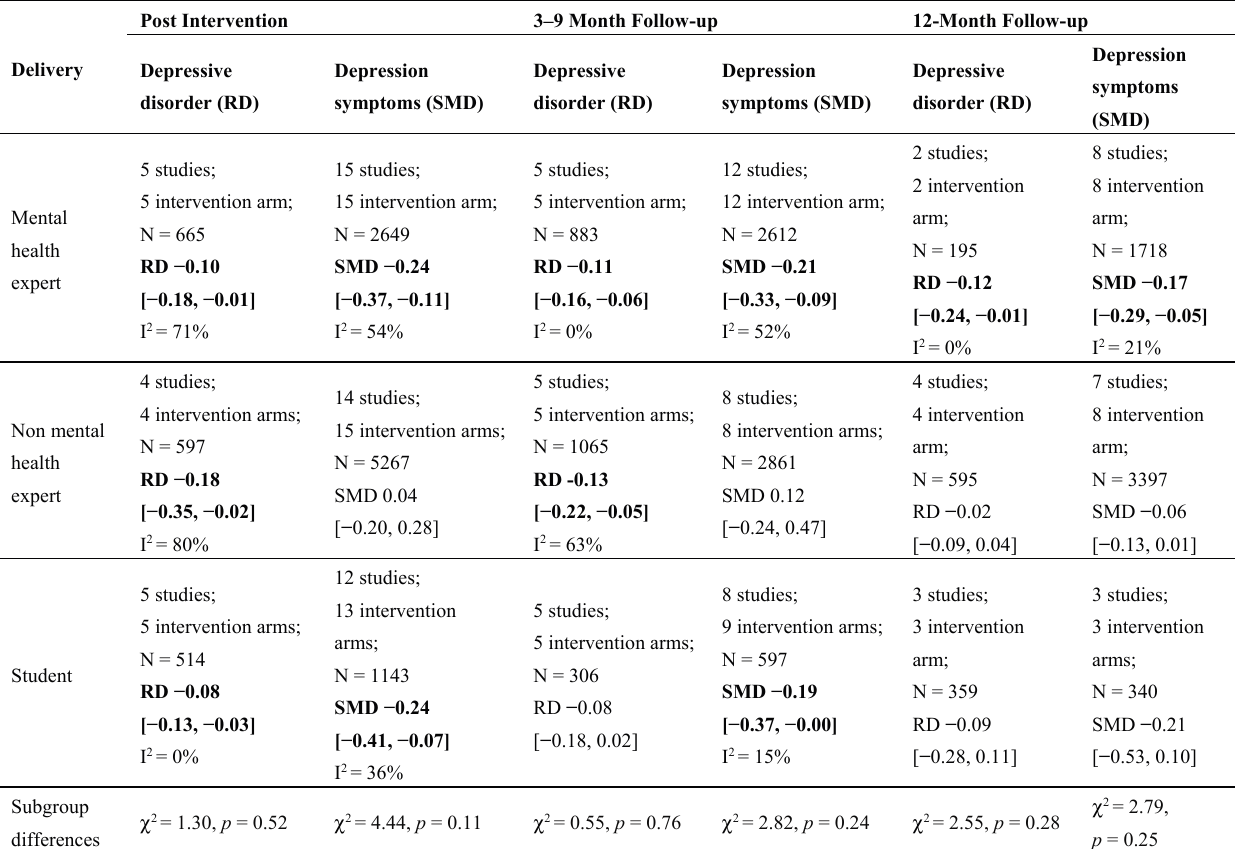
Table 7. Summary of meta-analysis results for approach to prevention programs analysed by who delivered the